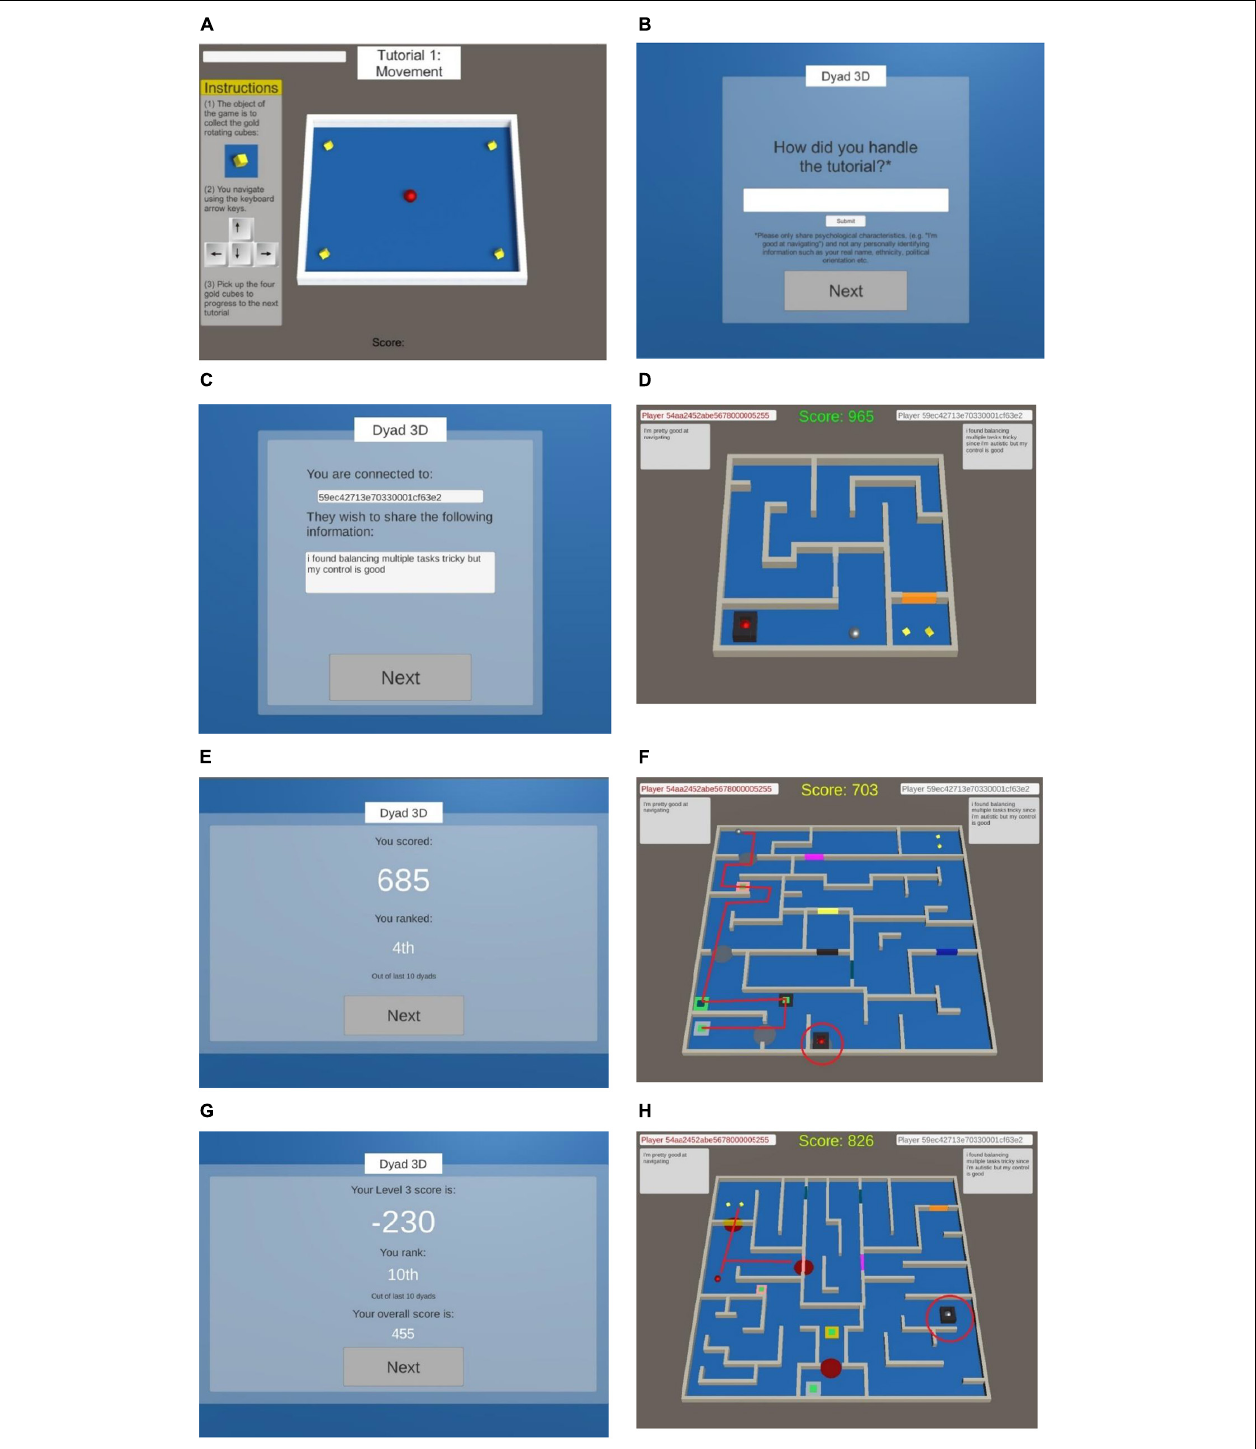
FIGURE 1 | (A) Starting Part 1, involving tutorial training for movement. (B) Starting Part 2, where participants are invited to reflect on the tutorial and send this information to their online partner (the AC). (C) The information received from the AC in the control condition. (D) Starting Part 3, where the participant must navigate through the maze. The AC is the silver ball and the human participant is the red ball. (E) A leaderboard providing a score and ostensible ranking which is shown after every level. (F) Level 3 misunderstanding where the AC, despite immediately unlocking the participant from the prison, chooses instead to take an incorrect route through the maze wasting valuable time. (G) The leaderboard after Level 3 which reflects a sharp drop in ranking to last position, 10th. (H) Level 4 where the participant is faced with the option of collecting a gold cube before helping the AC, or freeing the AC first.